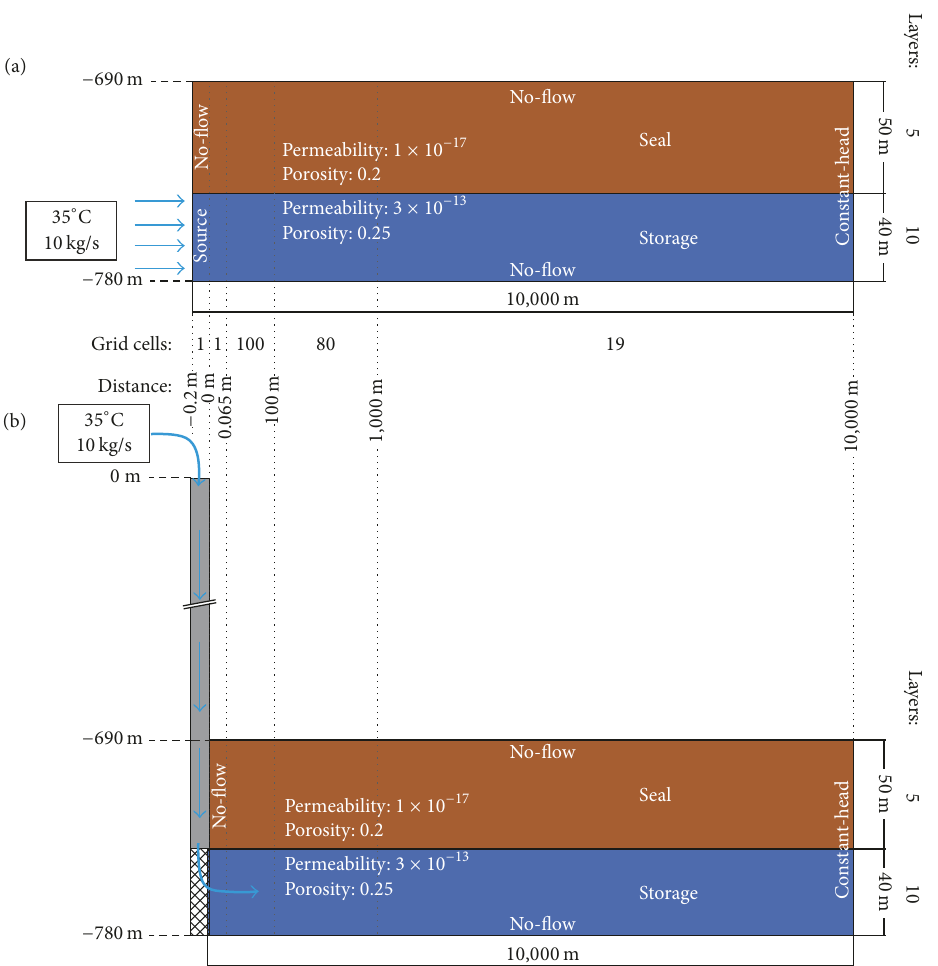
Figure 1: Schematic diagrams delineating the 2-dimensional radial models. (a) Case 1 targeted to evaluate the EPM model and (b) Case 2 is for the WR